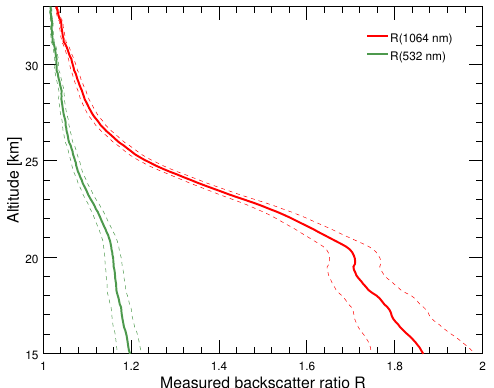
Figure 1. Monthly mean backscatter ratio profiles from lidar measurements during March 2013. Thick lines represent the mean values for the wavelengths 532nm and 1064nm. Dashed lines around the mean profiles indicate the error bands calculated as error of the